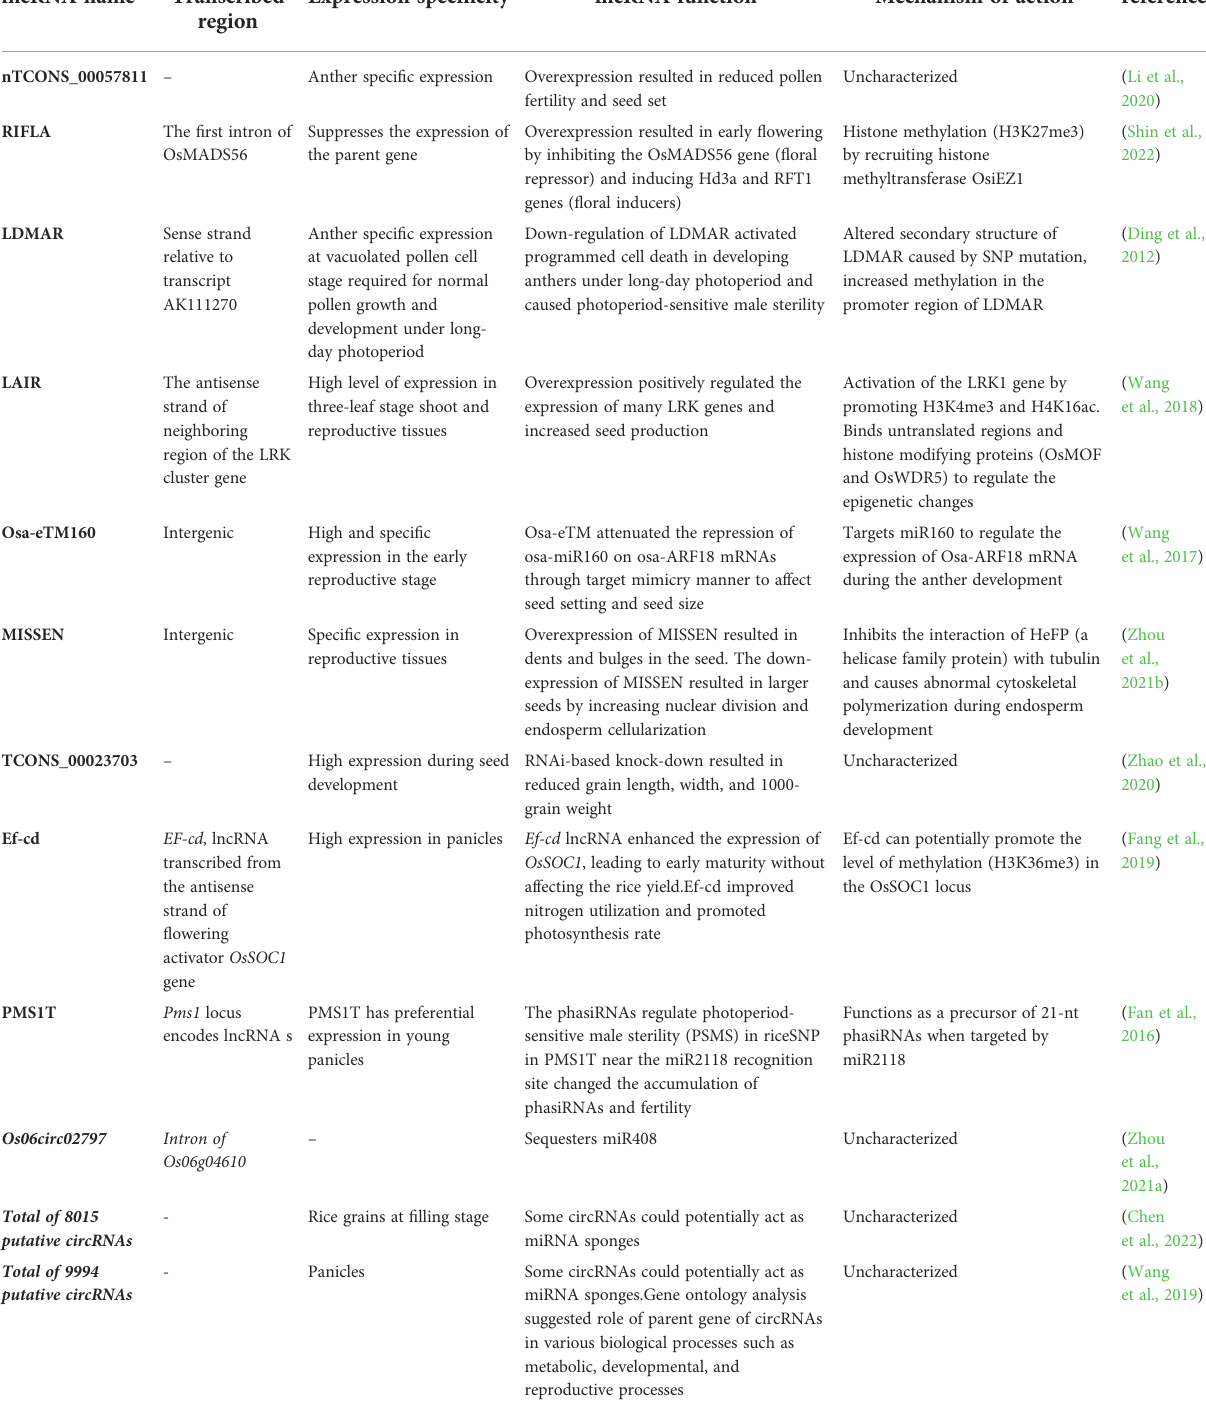
TABLE 1 A list of lncRNAs and circRNAs studied during rice